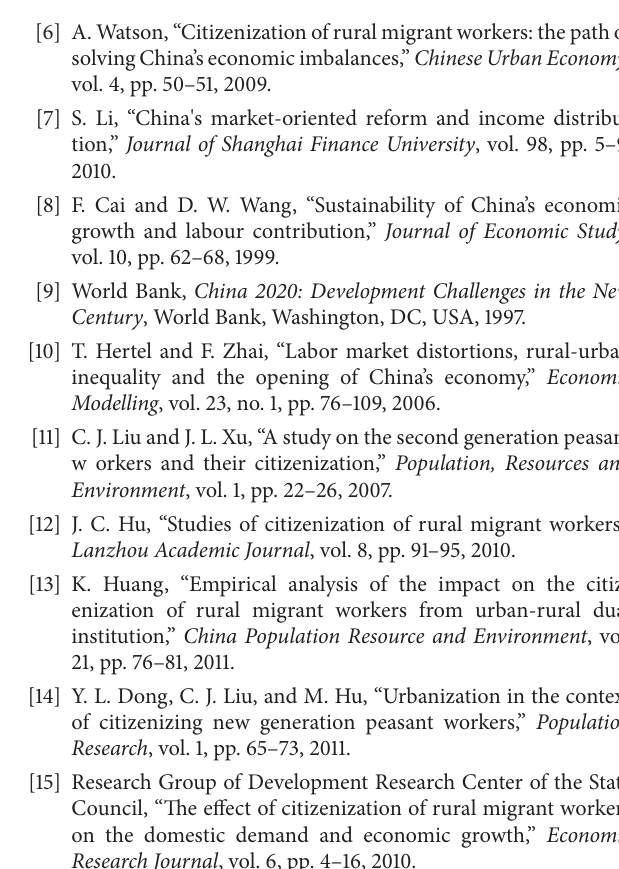
2 NonmetalProd represents Non-metallic mineral manufacturing; FerrMetals represents ferrous metal smelting and rolling processing industry;